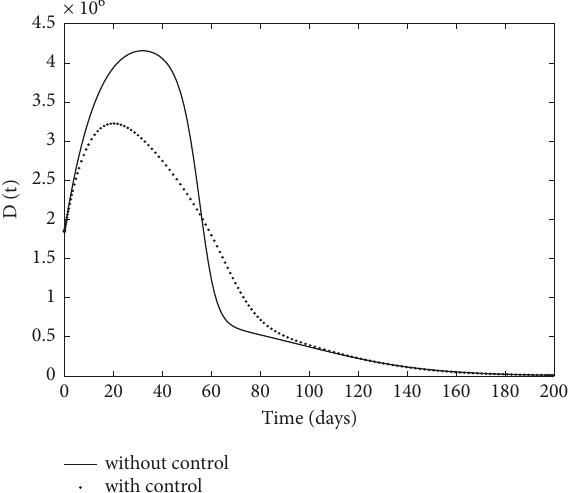
Figure 21: Behaviour of susceptible individuals with diabetes with and without